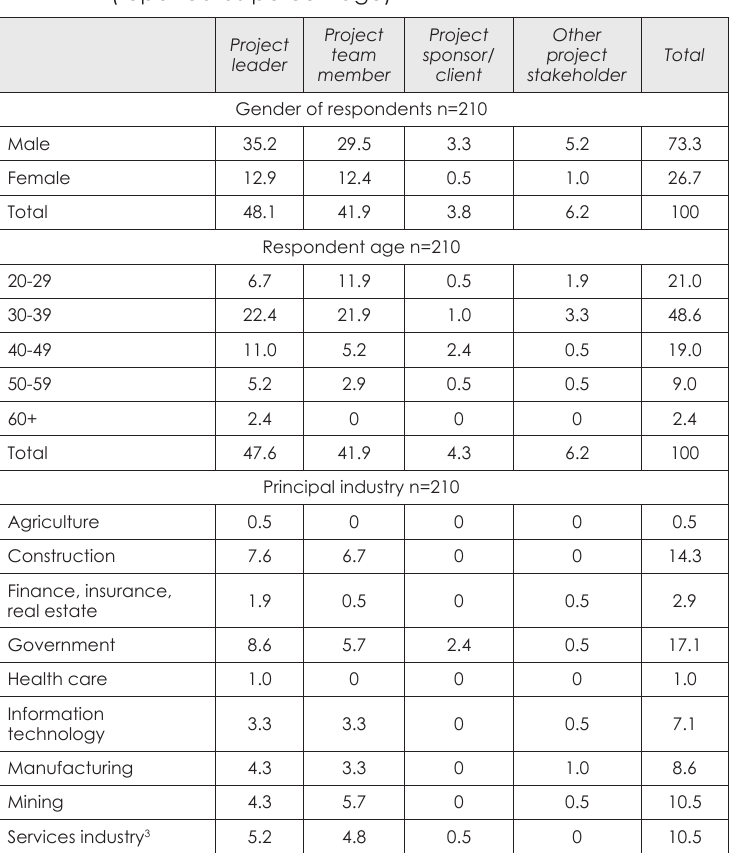
Summary of respondents’ profile by typical project